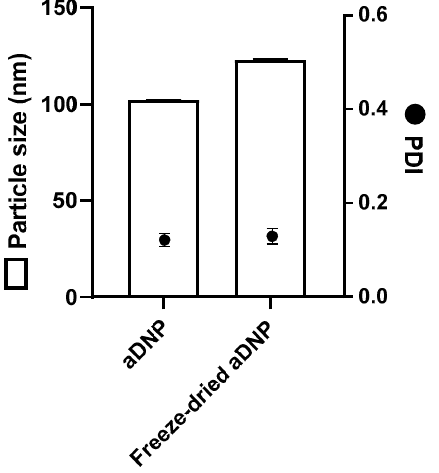
Figure 4. Freeze-drying of amino-dextran nanoparticle. Particle size and polydispersity index (PDI) of amino-dextran nanoparticles before and after freeze-drying. Data are presented as the mean ± S.D. ( n = 3).